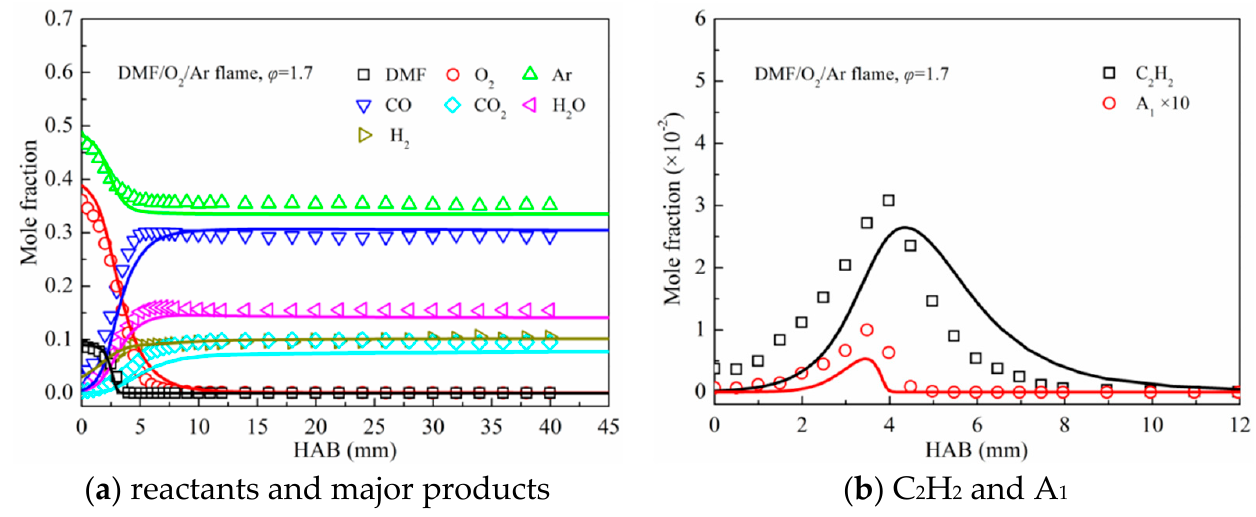
Figure 9. Measured [47] (symbols) and predicted (lines) species pro fi les in premixed DMF fl ame.